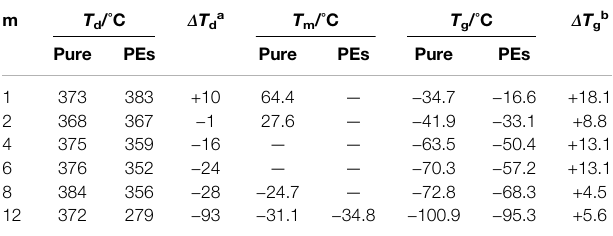
Thermal decomposition temperature (T d ) was determined as the intersection on the baseline and diagonal line of the most signi fi cant weight loss on the TG curves. Melting temperature(T m )wasde fi nedasthe intersectionofthebaselineanddiagonalline ofthe endothermicpeakontheDSCcurves.Glasstransitiontemperature(T g )wasdetermined as the intersection of the baseline and the diagonal line of baseline shift on the DSC curves.ThegapsofT d andT g betweenPCmEOandPCmEO-LiTFSAweredescribedas Δ T Δ T d and g , respectively. a Δ